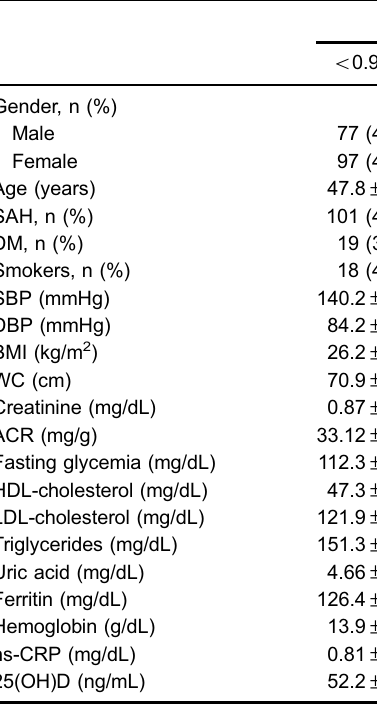
Table 4. Characteristics of the participants according to carotid intima-media thickness.